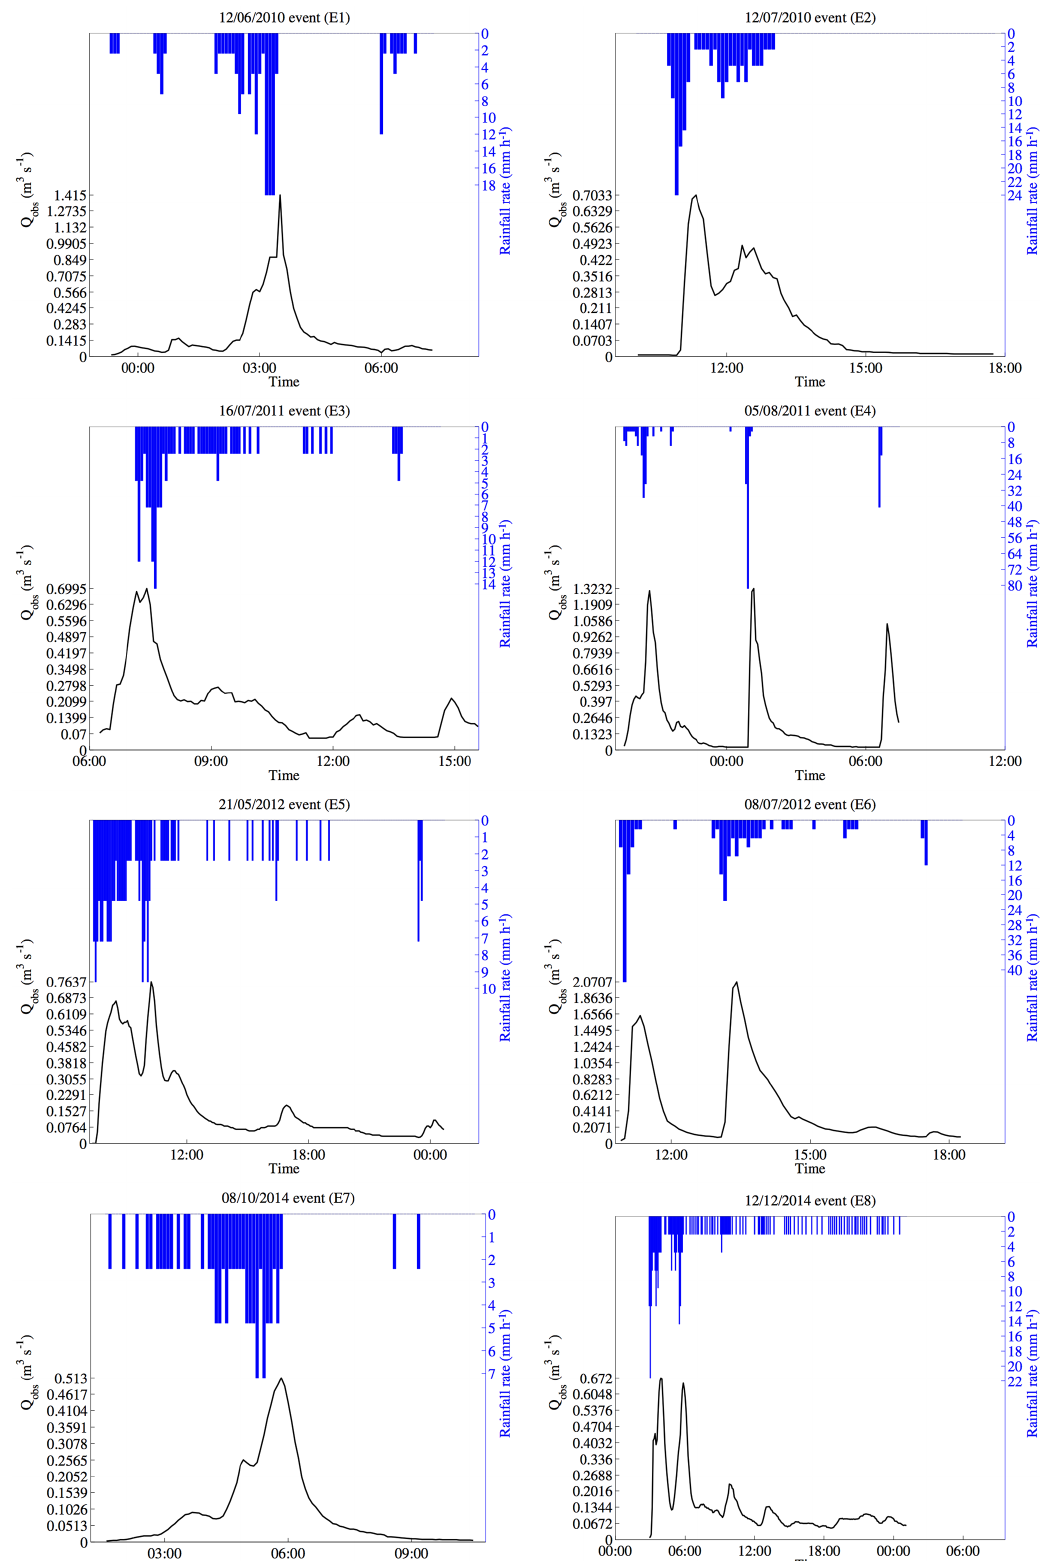
Figure 6. Rainfall data and the corresponding flow measurement available for the eight rainfall events selected to perform the multi-scale modelling